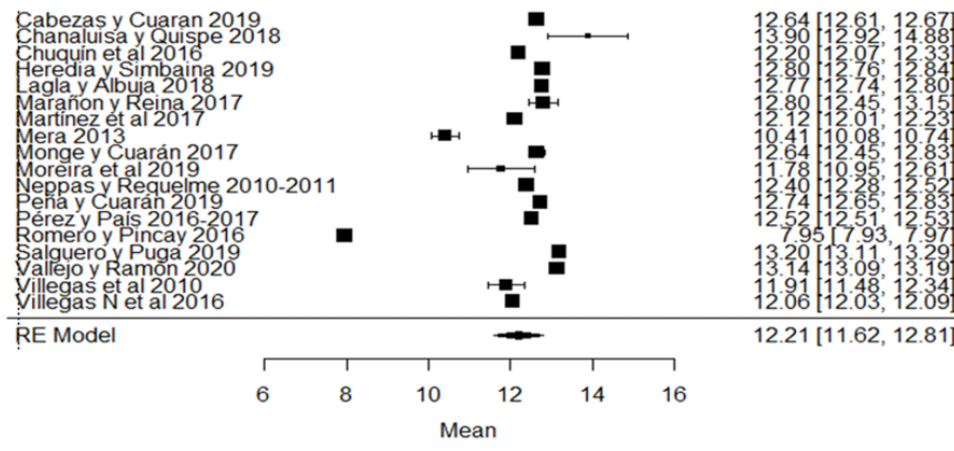
Figure 11. Forest plot of total solids [14,16 – 18,21,24,30,33,35,38,51,53,57,73,76,77,79,80].